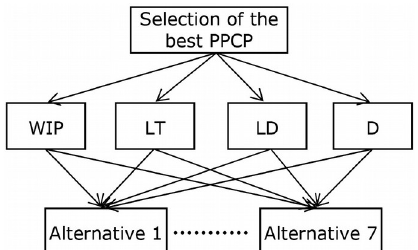
Figure 10. Decision making hierarchical